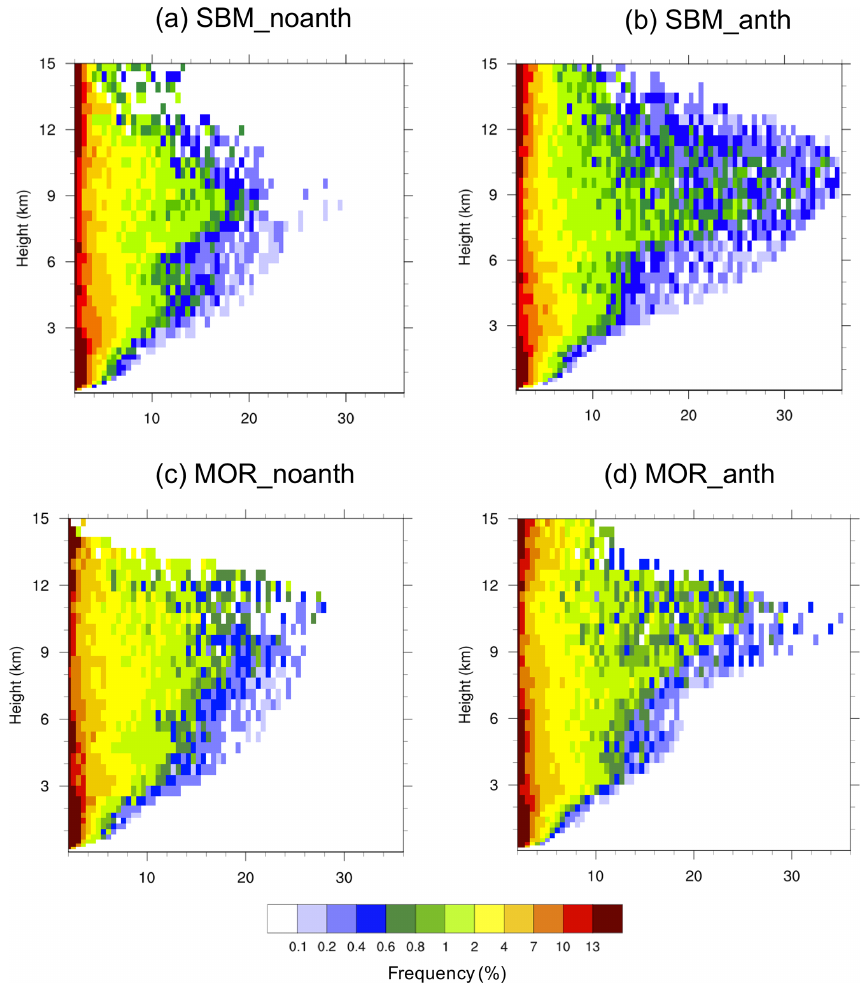
Figure 10. CFADs of updraft velocity (unit: ms − 1 ) for values larger than 2ms − 1 from (a) SBM_noanth, (b) SBM_anth, (c) MOR_noanth, and (d) MOR_anth over the study area (red box in Fig. 7) during the strong convection period (20:00–23:00UTC on 19 June 2013). The results are the three ensemble